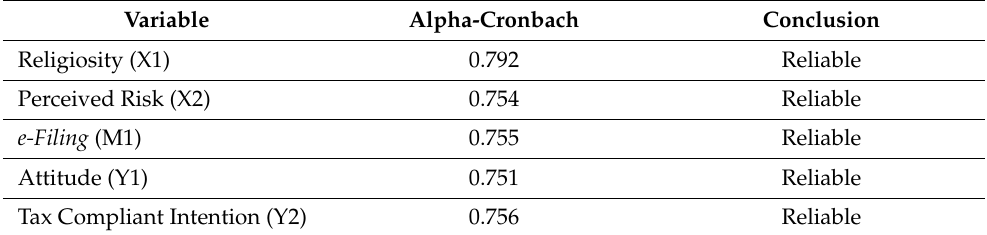
Table 2. Reliability